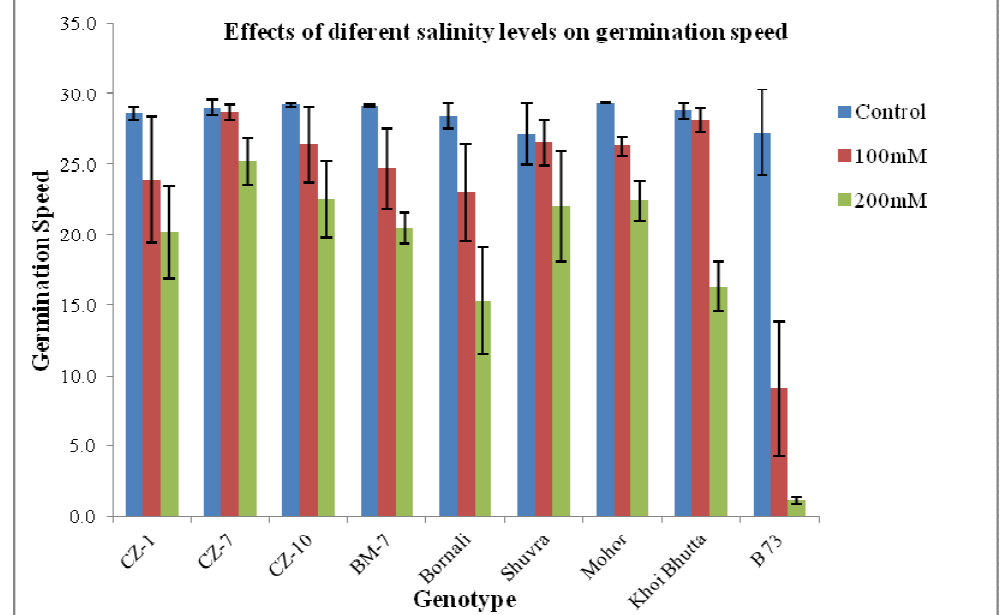
Fig. 2. Effects of different salinity levels on speed of germination.